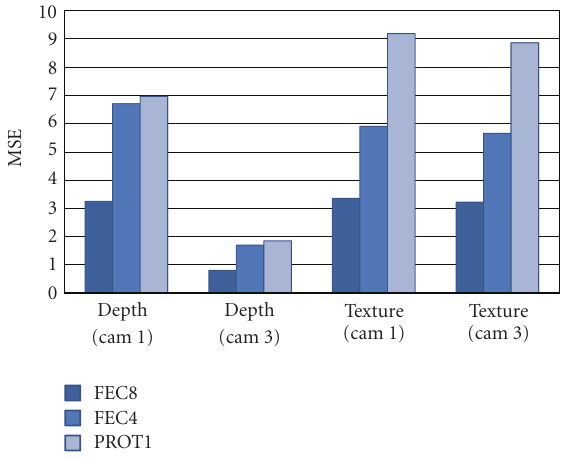
Figure 19: Performance at 10% packet loss rate: distortion due to depth (columns 1 and 2) and texture (columns 3 and 4) packet losses with di ff erent error protection schemes.